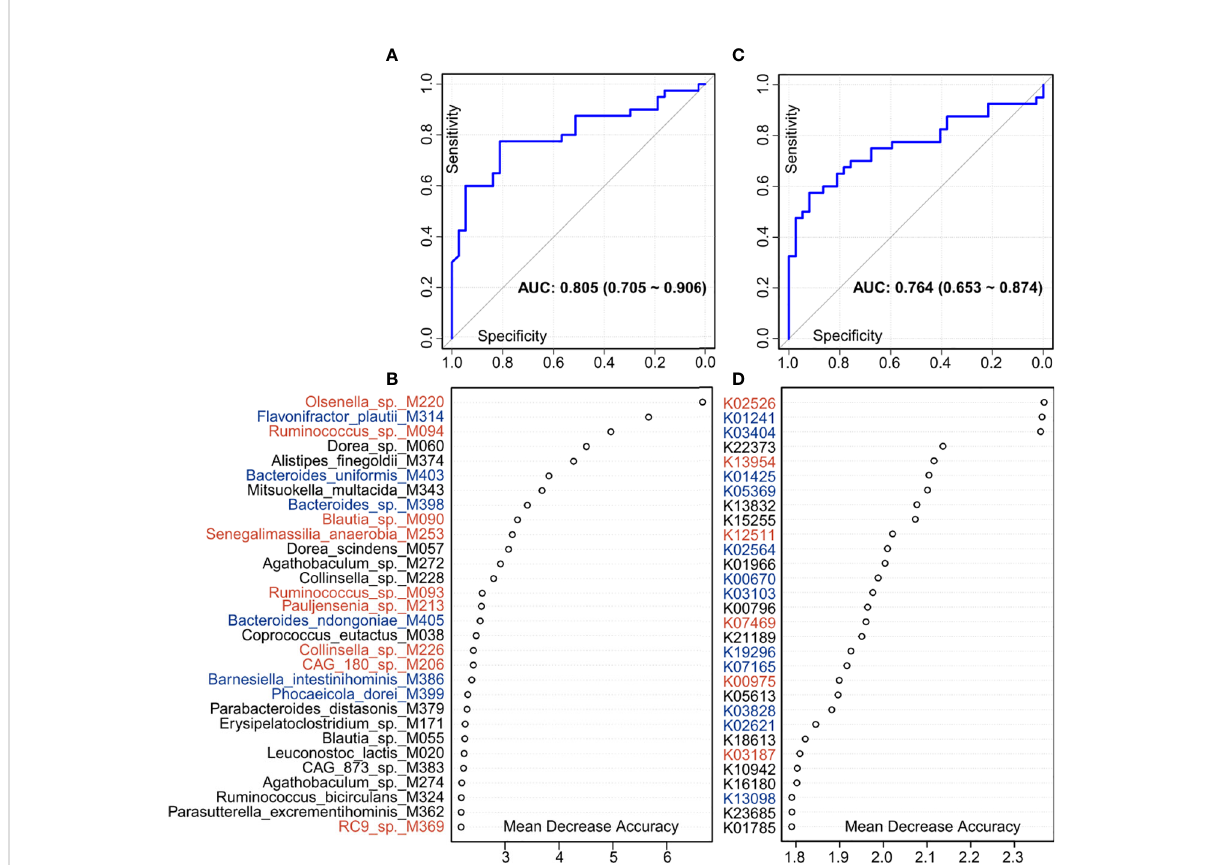
FIGURE 6 Classi fi cation of PE status by the relative abundances of gut microbial biomarkers. (A, C), ROC analysis for classi fi cation of PE patients and healthy controls by species (A) and KO (C) pro fi les, assessed by AUC. (B, D) The 30 most discriminant species (B) and KOs (D) in the model classifying patients and controls. Colors represent enrichment in PE patients (red) or healthy controls